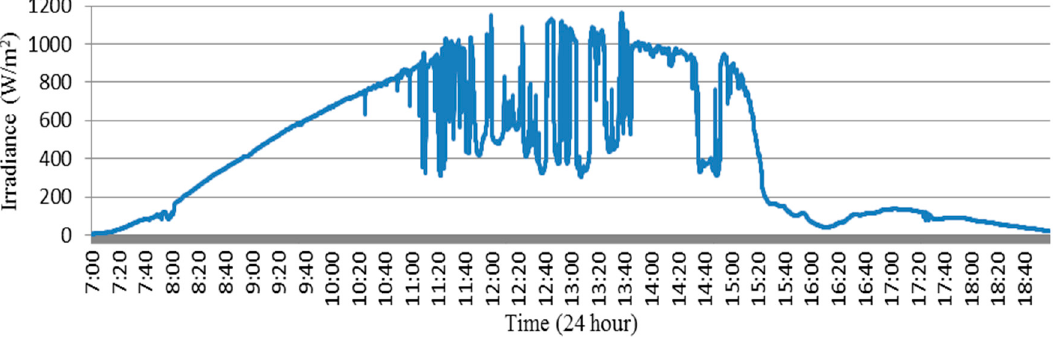
Figure 6. Example of one second sampled in-plane irradiance daily data in 2014 [4].